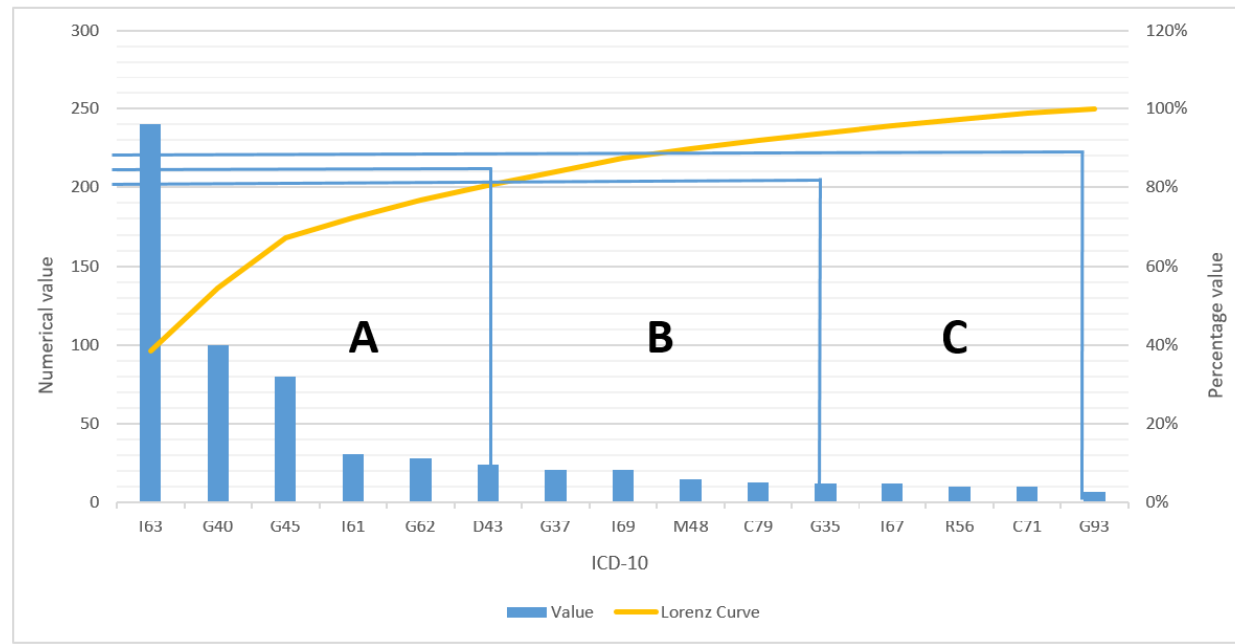
Scheme 2. ABC analysis of the occurring diseases according to